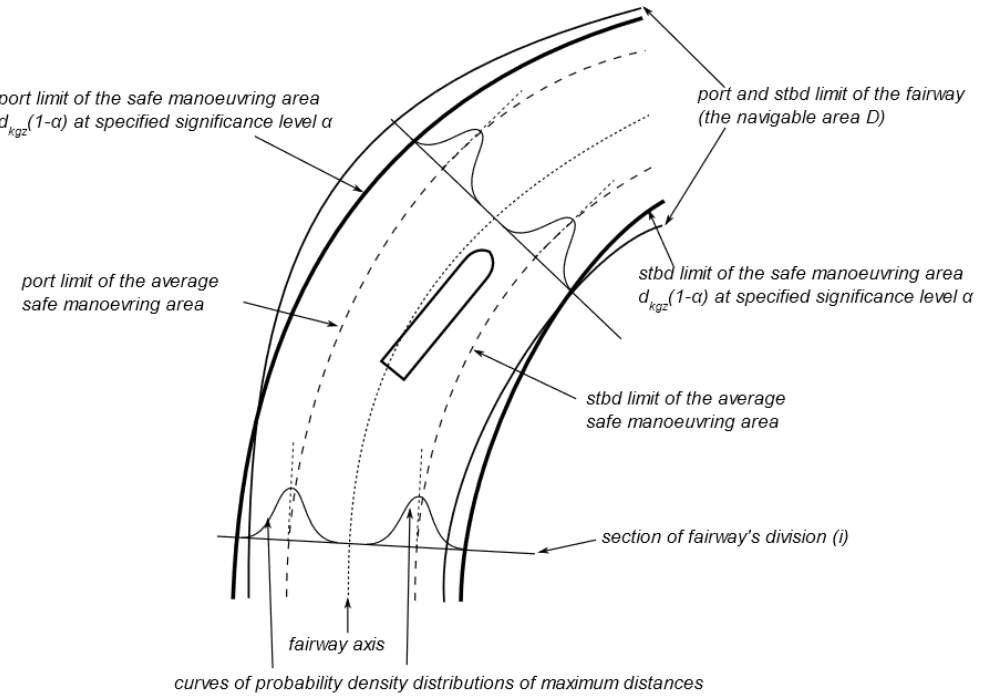
Figure 8. Construction of the safe manoeuvring area or VTE limits.